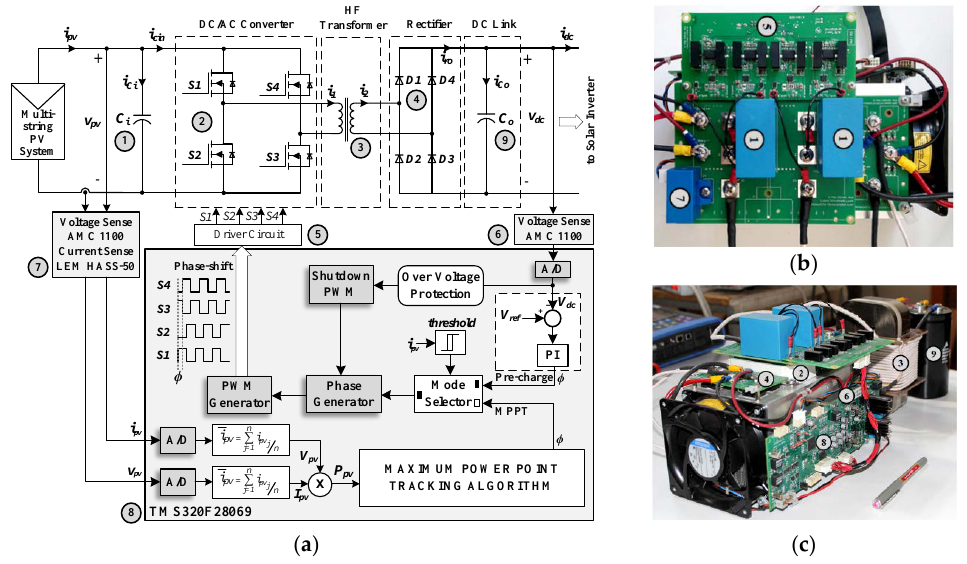
Figure 3. All SiC MPPT converter with high-frequency link: ( a ) power stage and its control circuitry; ( b ) yop view of the developed hardware; and ( c ) side view. (1) Metal Film 30//30 μF Input Capacitor Bank (EPCOS B32778G0306K); (2) All-SiC Half Bridge Module (CREE CAS120M12BM2); (3) Nanocrystalline Core (SU-102b) Based HF Transformer; (4) SiC Schottky Diode (CREE C4D40120D); (5) Dual Channel SiC MOSFET Driver (CREE CGD15HB62P); (6) Fully-Differential Isolation Amplifier (TI AMC-1100); (7) Hall-Effect Current Transducer (LEM HASS 50-S); (8) Microcontroller (TI TMS320F28069); (9) Electrolytic 3400 μF Output Capacitors (EPCOS B43456-A9688-M).